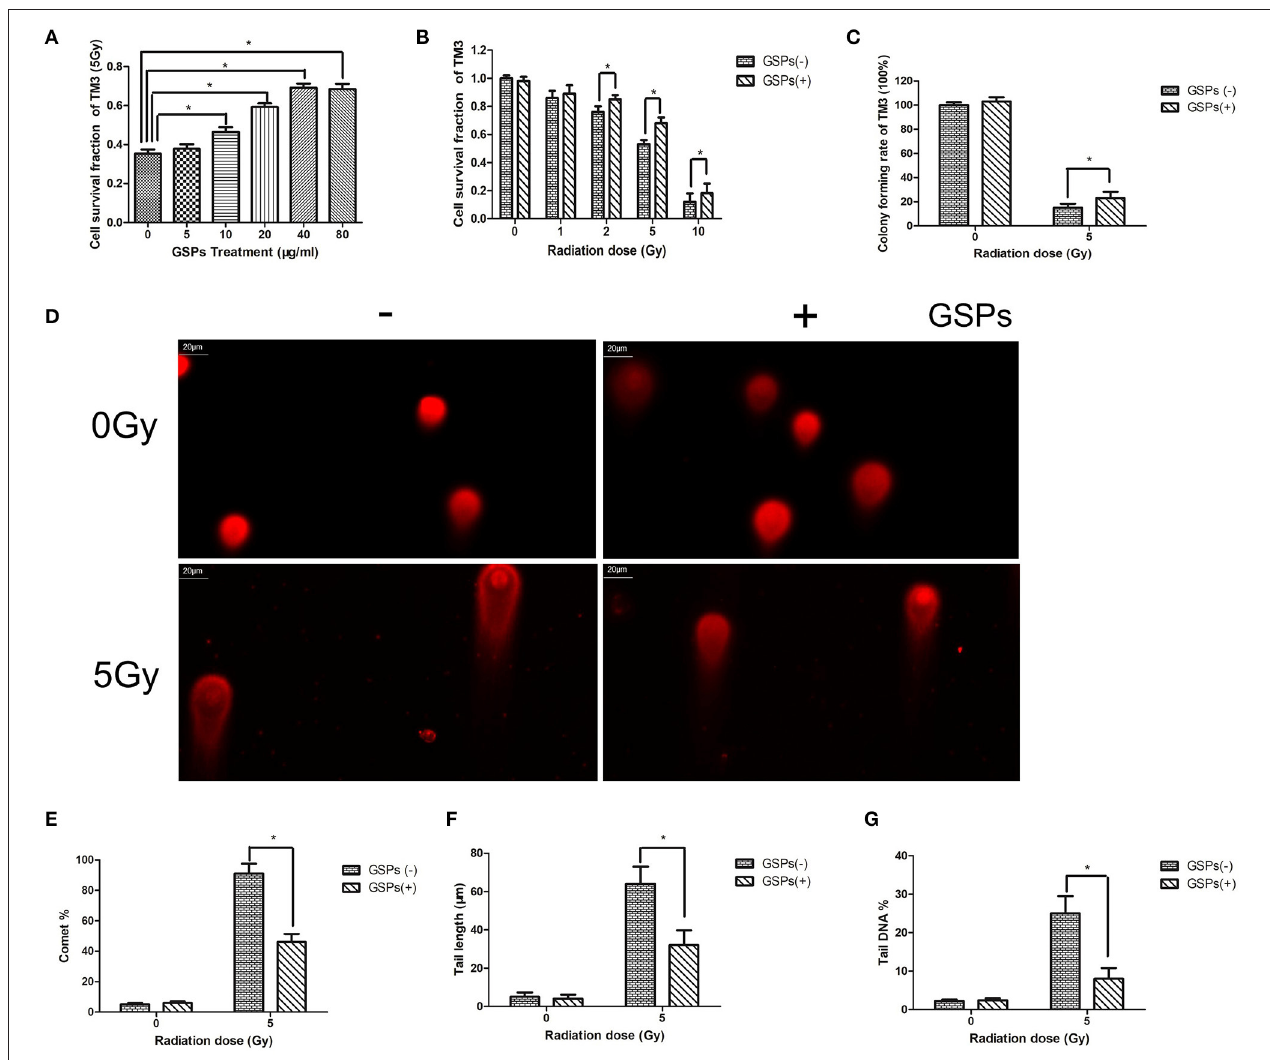
FIGURE 1 | Grape seed proanthocyanidins have a radioprotective effect on mouse testicular stromal cells TM3. (A) When TM3 cells are exposed to 5Gy ionizing radiation (IR), the radioprotective effect of grape seed proanthocyanidins (GSPs) is dose-dependent. (B) The viability of TM3 cells gradually decreases with the increase of the radiation dose, while GSPs increase the vitality of irradiated TM3 cells. (C) The clone formation assay shows that GSPs increase the proliferation ability of irradiated TM3 cells. (D–G) Effect of GSPs in TM3 cells on IR-induced DNA strand breaks assayed by comet assay. (D) Representative micrographs. (E) Comet%. (F) Tail length. (G) Tail DNA%. Data are presented as mean ± SD ( n = 6). * P <